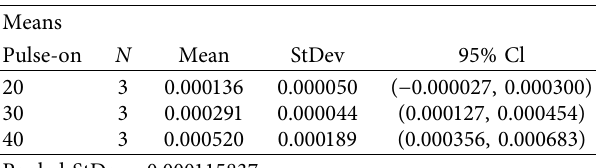
Table 10: Mean and standard deviation at different pulse-on times for